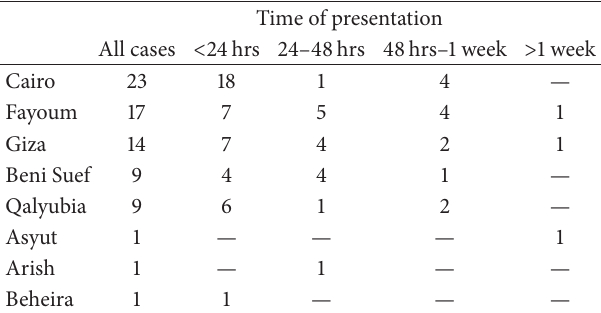
Table 1: The timing of presentation and amount of delay for each governorate.